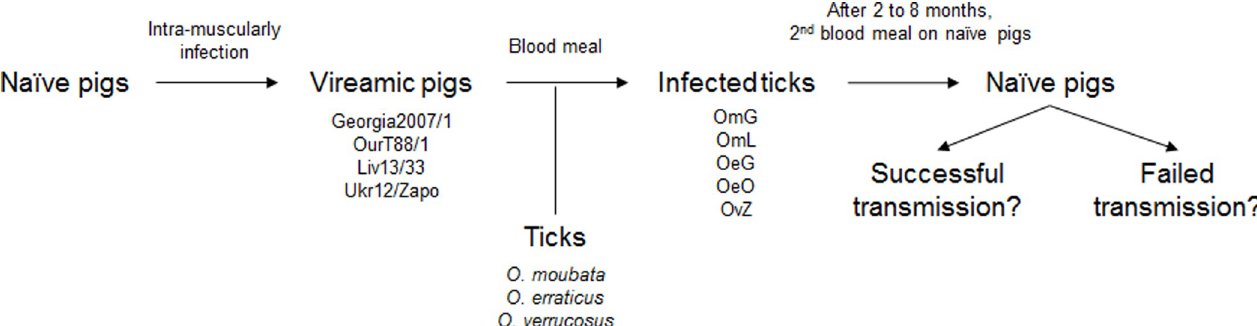
Fig 1. Experimental outline of experiments using viremic pigs to attempt soft tick infection depicting subsequent tests for ASFV transmission to pigs. Viremia was produced by inoculating na ï ve pigs intramuscularly with ASFV. Infection of three Ornithodoros soft tick species was attempted by allowing the ticks to blood feed on the viremic pigs. Two to eight months after feeding on viremic pigs, additional experiments were conducted to test the ability of these ticks to transmit different ASFV strains while acquiring a blood meal on na ï ve pigs. OmG: O . moubata -Georgia2007/1, OmL: O . moubata -Liv13/33, OeG: O . erraticus -Georgia2007/1, OeO: O . erraticus -OurT88/1, OvZ: O . verrucosus -Ukr12/Zapo.